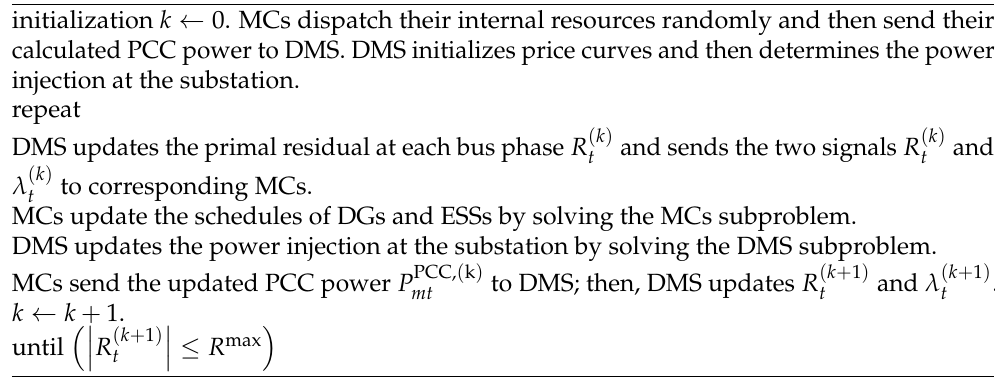
Algorithm 1 ADMM-based distributed energy management for networked microgrids.